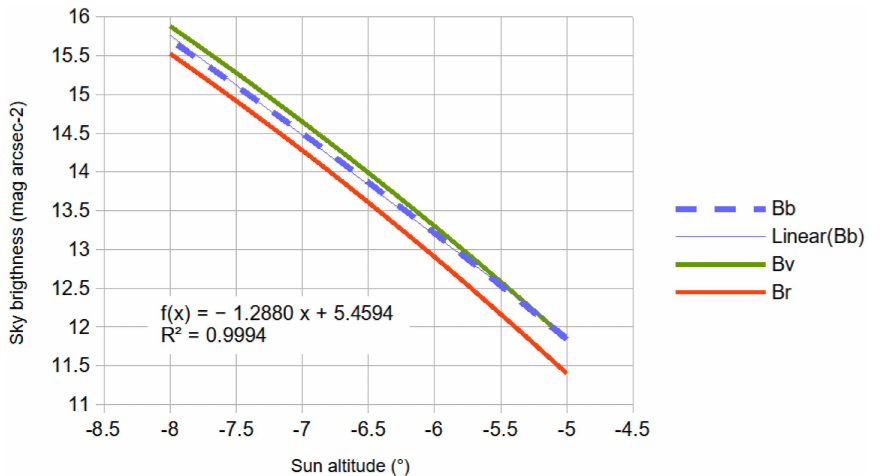
Figure 2. Trends of the sky brightness at zenith for BVR Johnson-Cousins system passbands according to the model presented in [50] and of the linear approximation of the model related to the B filter in the interval [ − 8 ◦ , − 5 ◦